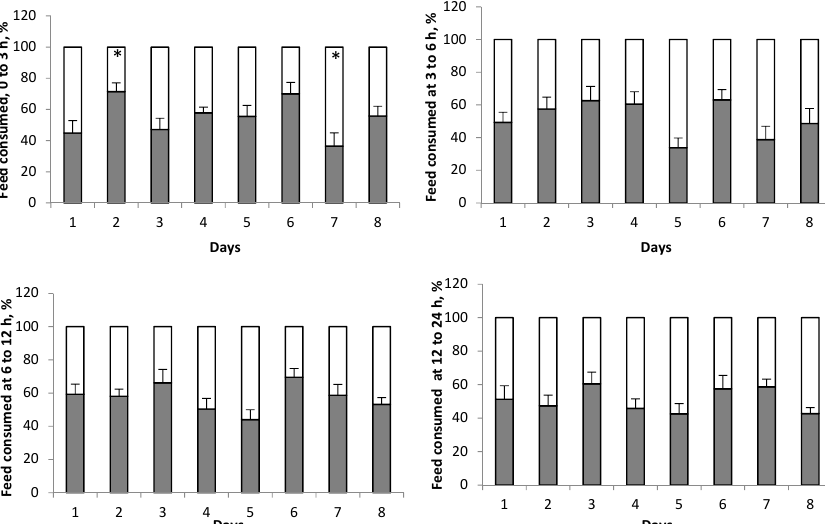
Figure 4. Proportions of a grain diet without (white portion of the bars) or with 3-NOP (black portion of the bars) consumed at 0 to 3, 3 to 6, 6 to 12, and 12 to 24 h after feeding during the preference period ( n = 9; Exp. 2). Day 1 to 8 corresponds to the 8 d preference period. The symbol * indicates that proportion of CON diet consumed minus proportion of 3-NOP diet consumed within day is not equal to 0 ( p < 0.05). No linear change in intake of 3-NOP diet, as a percentage of total daily dry matter intake, was observed over the 8 day preference period for any of the times after feeding.